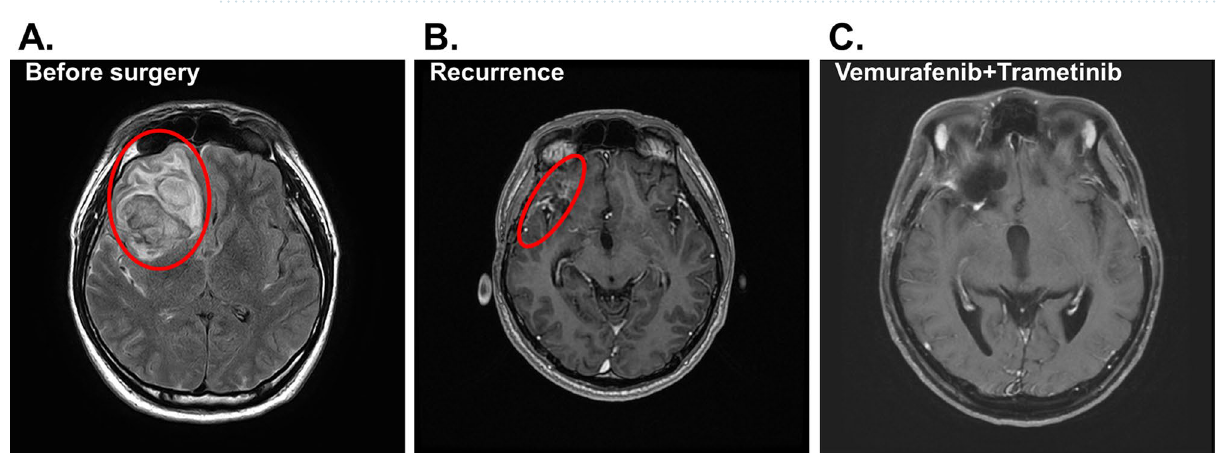
Figure 2. Radiological response of the brain lesion of patient #1 to BRAF inhibition. ( A ) Axial MRI before surgery with the tumor area circled. ( B ) The follow-up MRI image after surgery. ( C ) The follow-up axial image after combined treatment by vemurafenib and trametinib. Patient shows complete